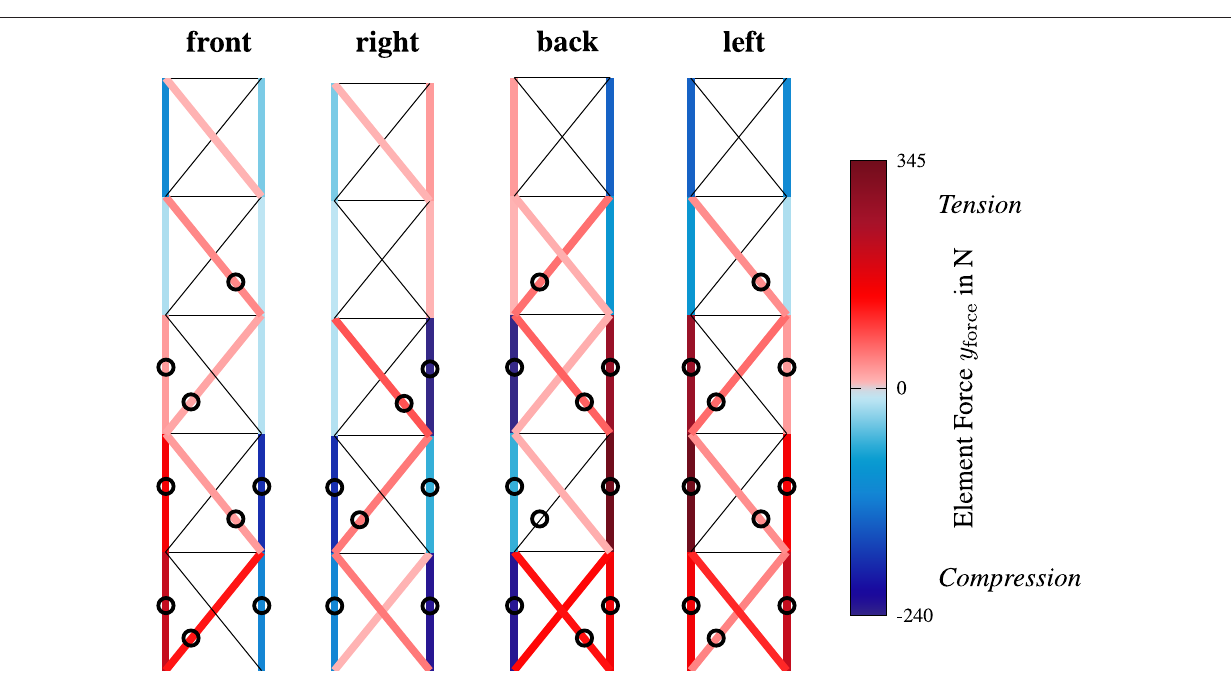
FIGURE 10 | Measured element forces for the structure under load and with active compensation, as in Figure 5C . Elements without a color are unmeasured or slack. Tension is indicated in red and compression in blue. Actuated elements are marked with a circle. The title indicates the viewing